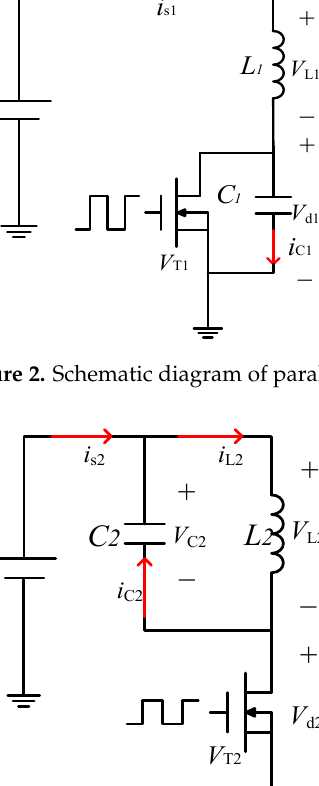
Figure 2. Schematic diagram of parallel resonance of an IDC transmitter circuit. Figure 3. Schematic diagram of a traditional transmitter circuit. Figure 3. Schematic diagram of a traditional transmitter Figure 3. Schematic diagram of a traditional transmitter circuit.